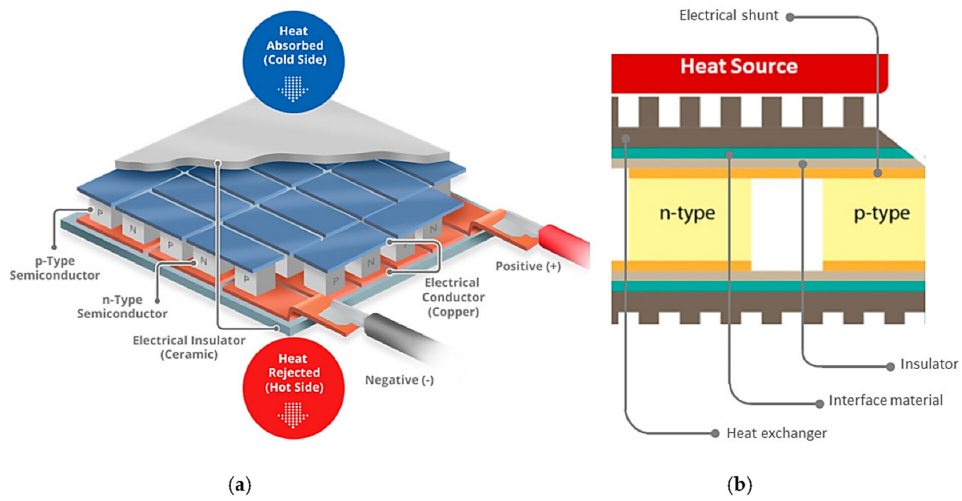
Figure 1. Basic configuration of a thermoelectric module and its working principle for TEG and TEC. ( a ) Schematic of heat transport from cold side to hot side when electric current is applied to thermoelectric cooler. ( b ) Cross-section of a typical thermoelectric module consisting of thermal and electrical insulation and interface materials. Reproduced with permission from